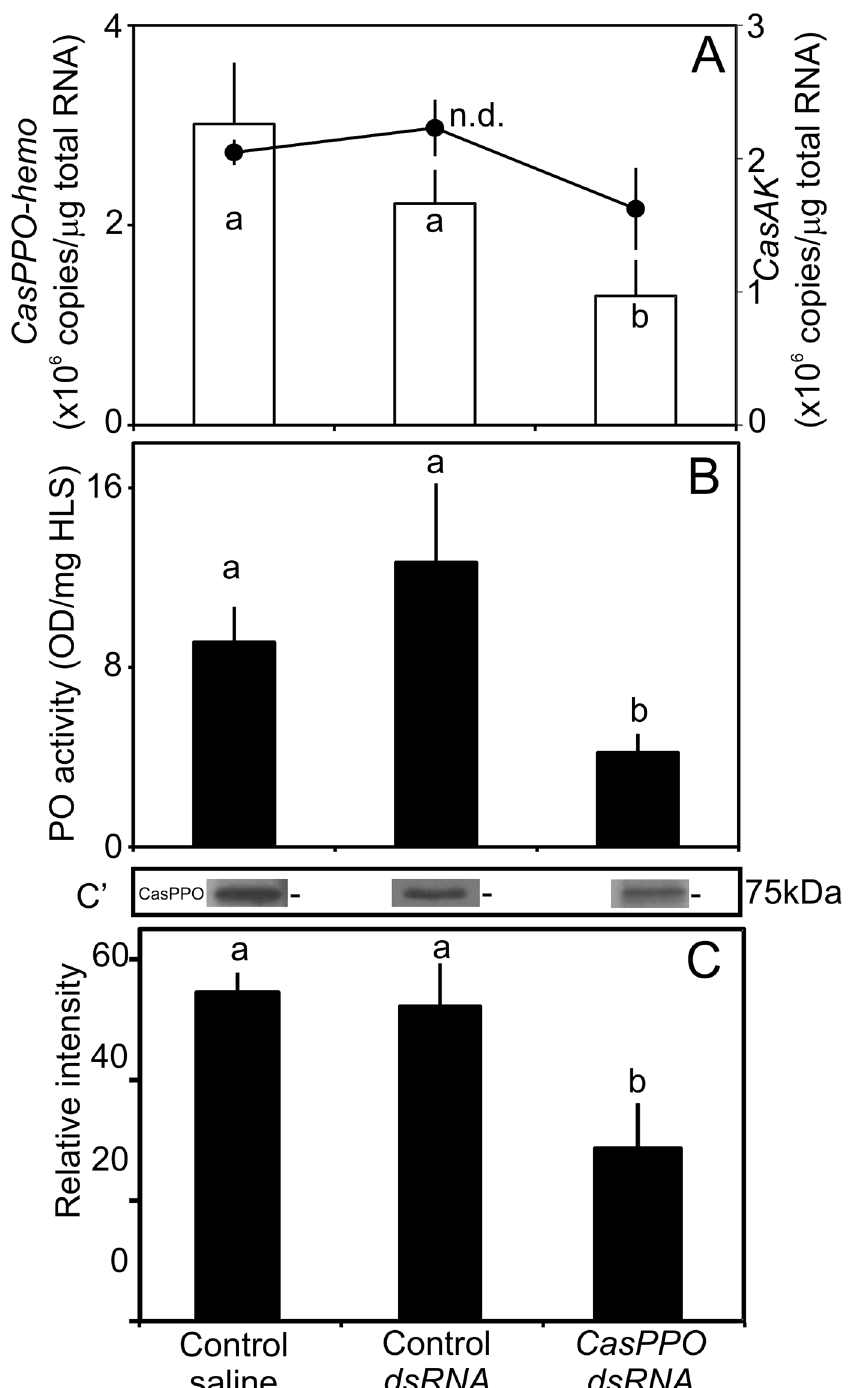
Fig 1. Effects of multiple injections of CasPPO-hemo-dsRNA on shell-hardness. Intermolt crabs (n = 7/ group) were injected with 10 μ g of CasPPO-hemo-dsRNA , control dsRNA, or saline every other day until ecdysis. (A) Levels of CasPPO-hemo transcripts, 24 hrs after ecdysis, (bars) in hemocytes (n = 7) and levels of CasAK transcirpts (line) in the same cDNA samples that are assayed as a reference gene. Different letters denotes the significant differences at P < 0.05. (B) CasHLS-PO activity at postmolt (24 hrs after ecdysis, n = 7). (C) The western blot analysis (c ’ ) identifies the presence of CasPPO-hemo in CasHLS in the samples. n.d. = no statistical